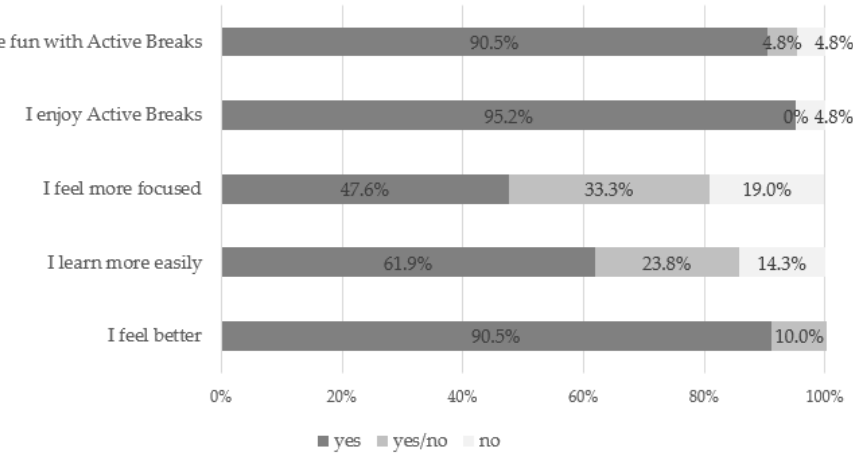
Figure 3. Children’s answers to the AB questionnaire.